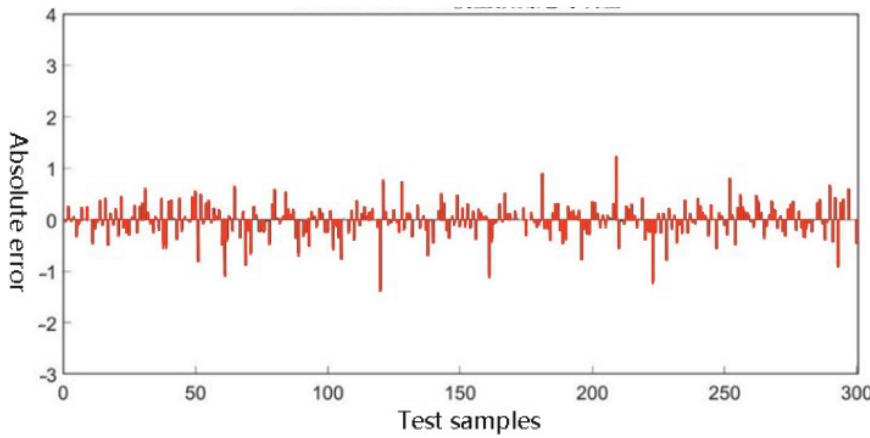
Figure 6. Comparison of predicted value and expected value of PCA-IPSO-ELM model.